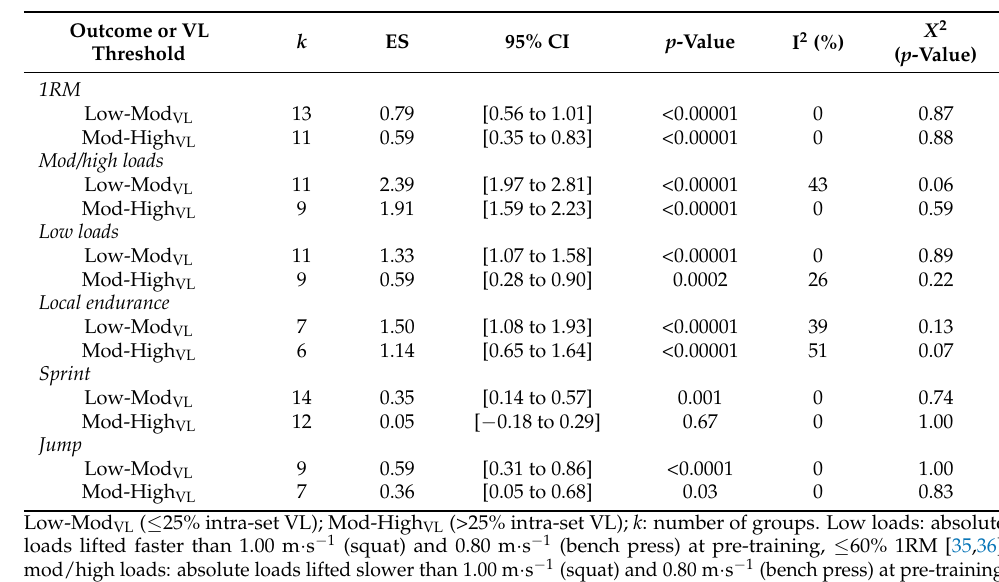
Table 4. Within-group analysis showing the pre-post training effects of Low-Mod VL and Mod-High VL thresholds.